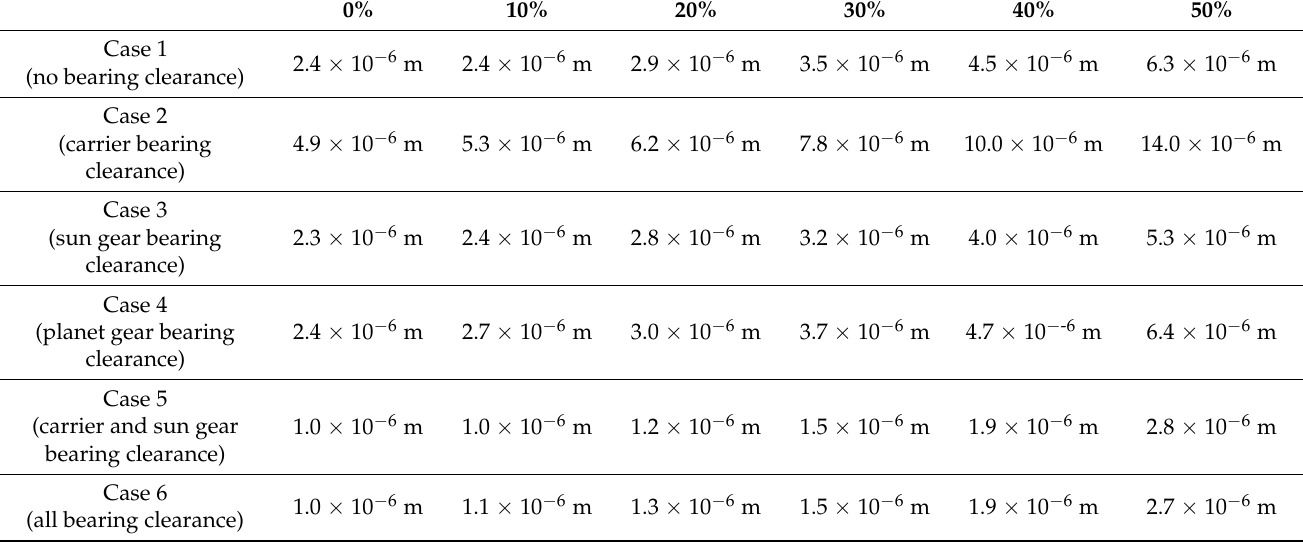
Table 5. The maximum value in the time domain for each case with different crack levels.